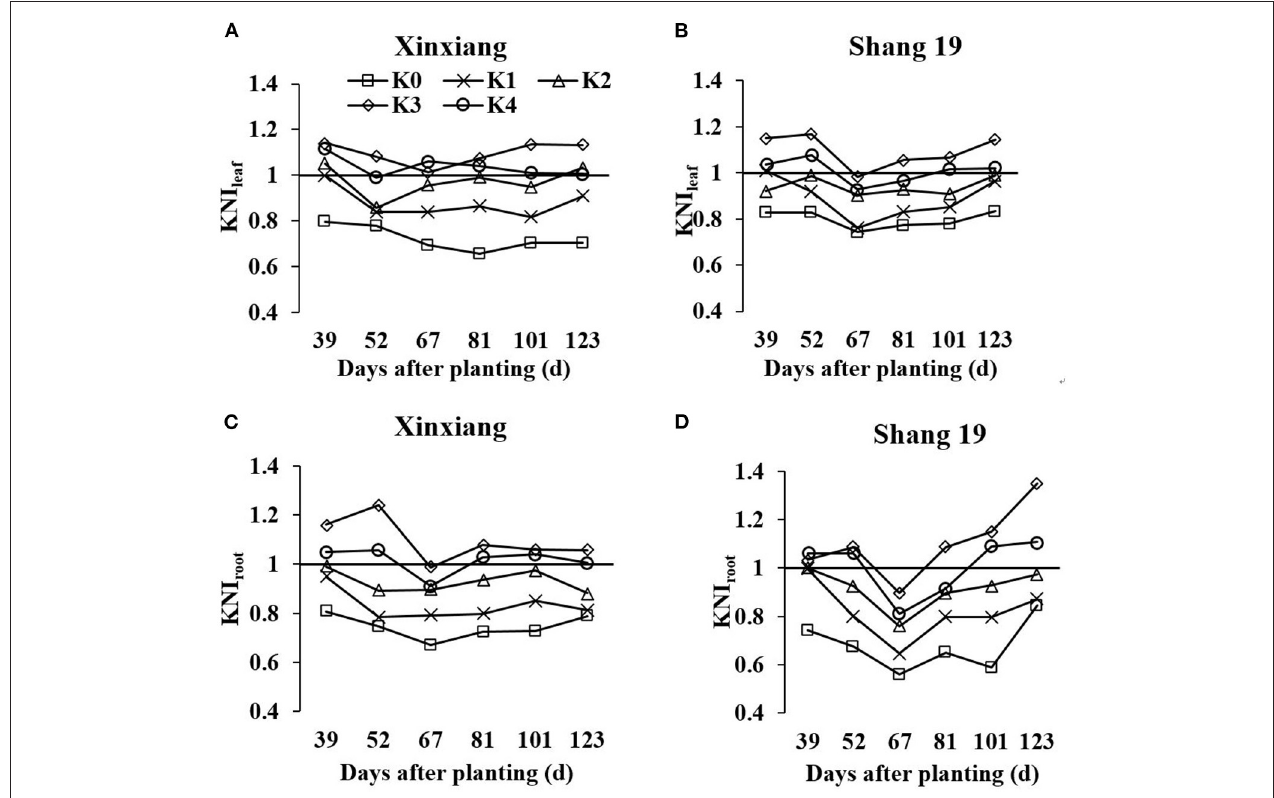
FIGURE 8 | Relationship between KNI leaf and KNI root .